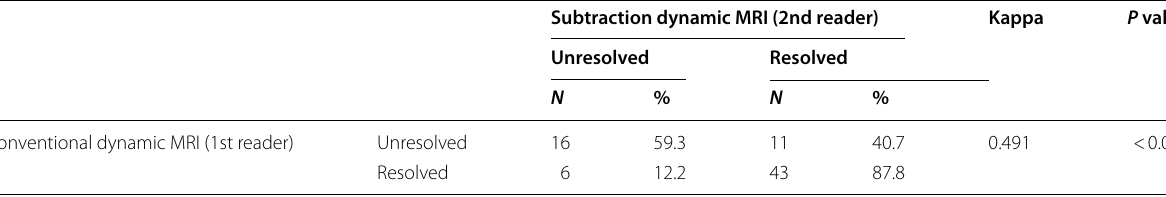
Table 1 Cross tab agreement and additive value of subtraction MRI compared to conventional dynamic MRI